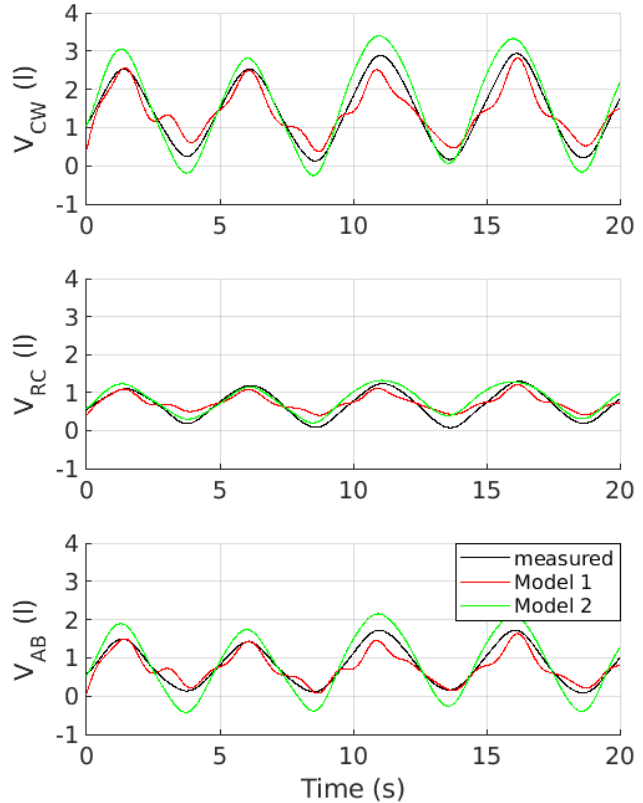
Figure 5. From top to bottom, the panels show a representative example of the tidal volume measured by optoelectronic plethysmography ( black curves ) and estimated by both Model 1 ( red curves ) and Model 2 ( green curves ) and related to the chest wall (V CW ), rib cage (V RC ), and abdominal (V AB ) compartments.